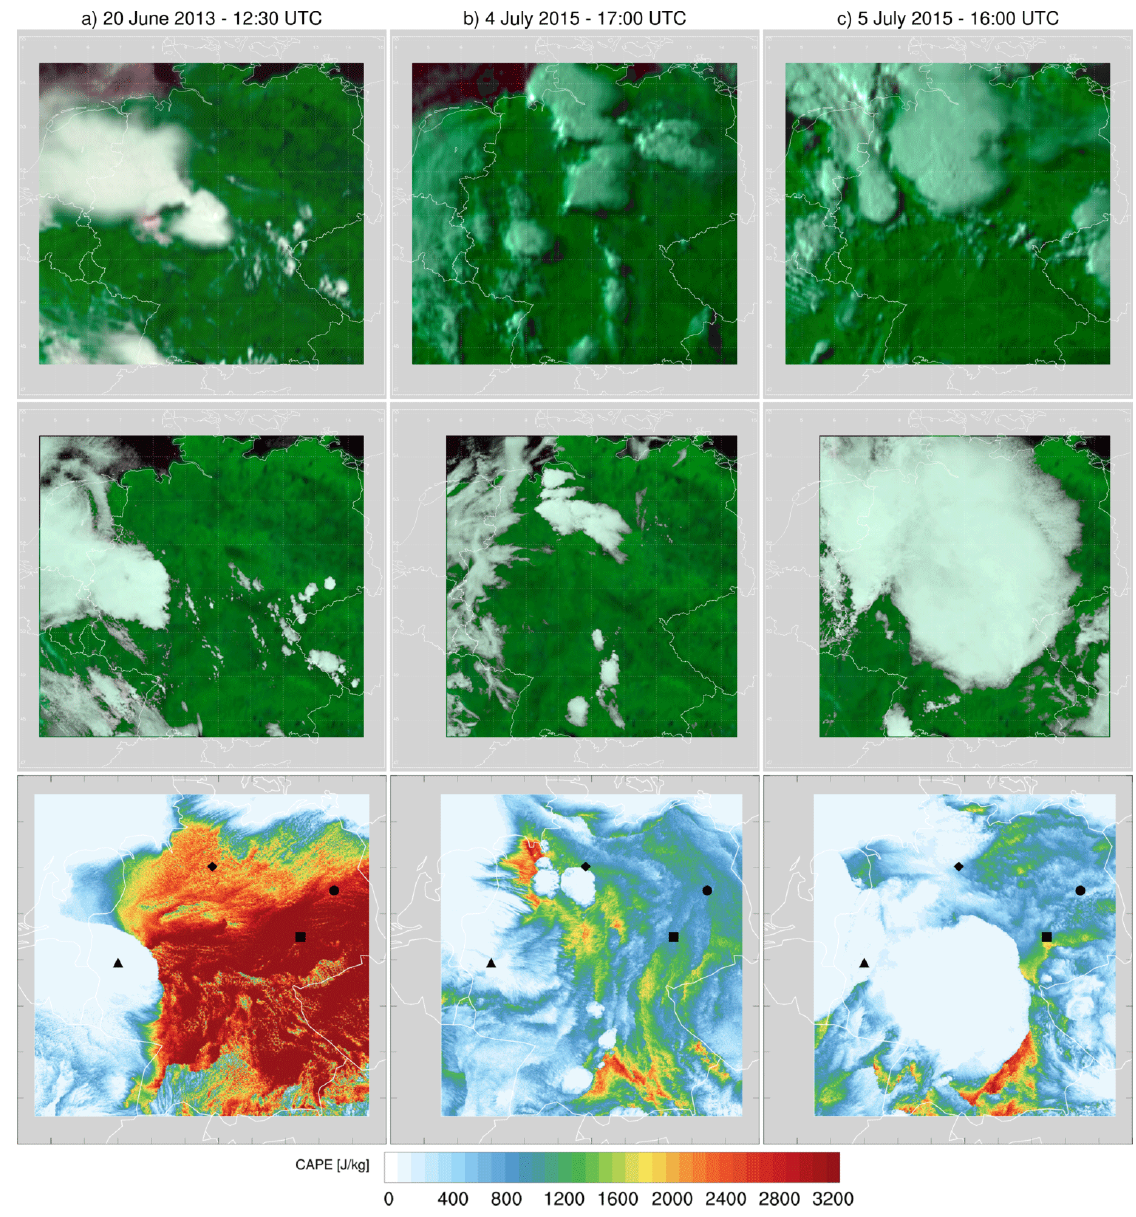
Figure 1. Synoptic situation as seen by SEVIRI for specific snapshots of the three selected days (upper row). Synthetic SEVIRI images of simulated cloud fields created with RTTOV are shown in the middle row. The false-color satellite images, both real and simulated, use the 0.6µm reflectance for the red band, the 0.8µm reflectance for the green band, and the average of the red and green bands for the blue band. Simulated CAPE values are displayed in the last row including the location of ground-based observational sites and initial release points of radiosondes: Bergen (diamond), Lindenberg (circle), Jülich (triangle), and Leipzig (square). SEVIRI images show the area from 47.6 to 54.5 ◦ N and 4.5 to 14.5 ◦ W. Due to a change in the model domain for the 4 and 5 July simulations the western border is shifted by 1 ◦